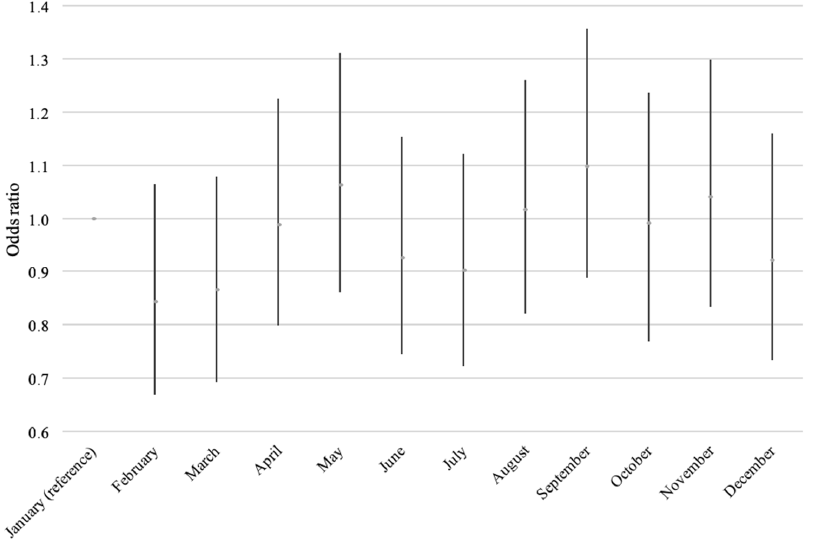
Figure 3. Odds of incident IBD according to the month of birth, adjusted for sex and prenatal exposure to extra vitamin D from the fortification policy.